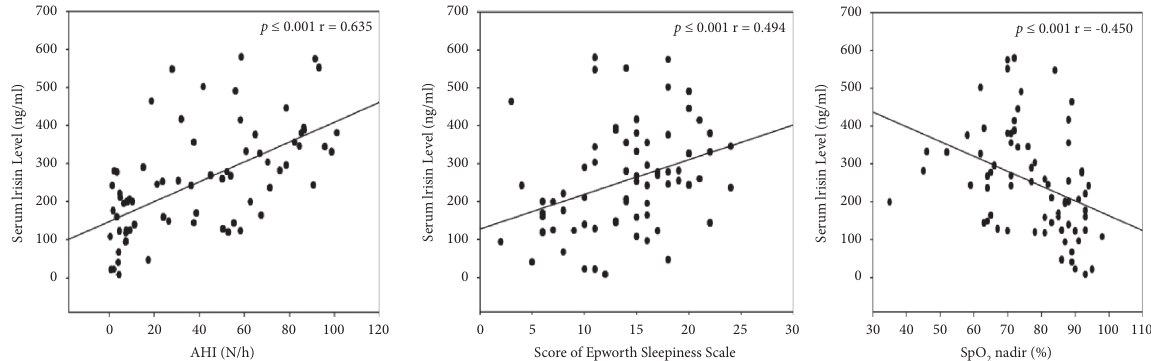
Figure 2: Correlation between serum irisin level and ESS, AHI, and SpO